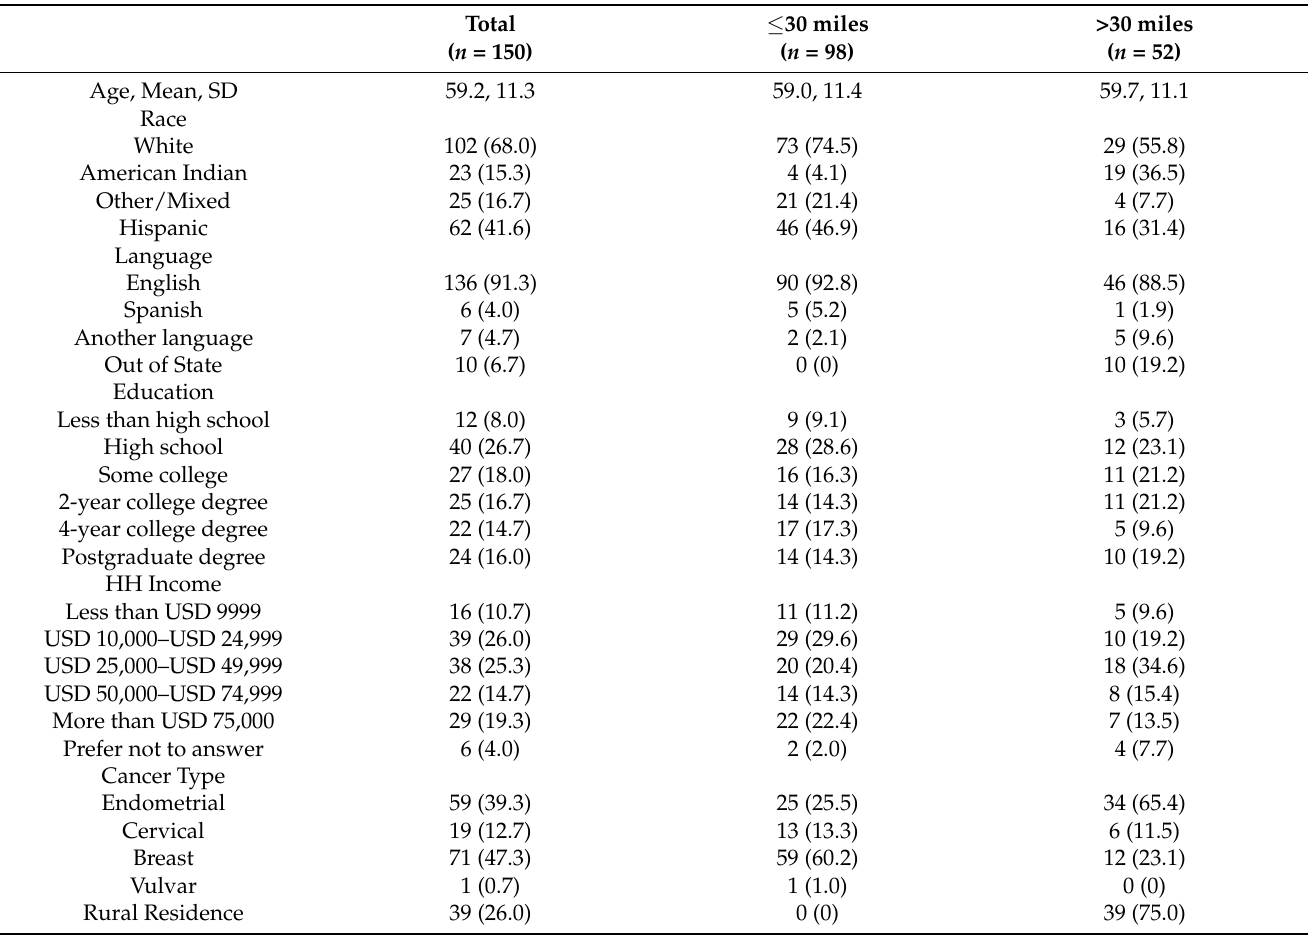
Table 1. Respondent Demographics, n